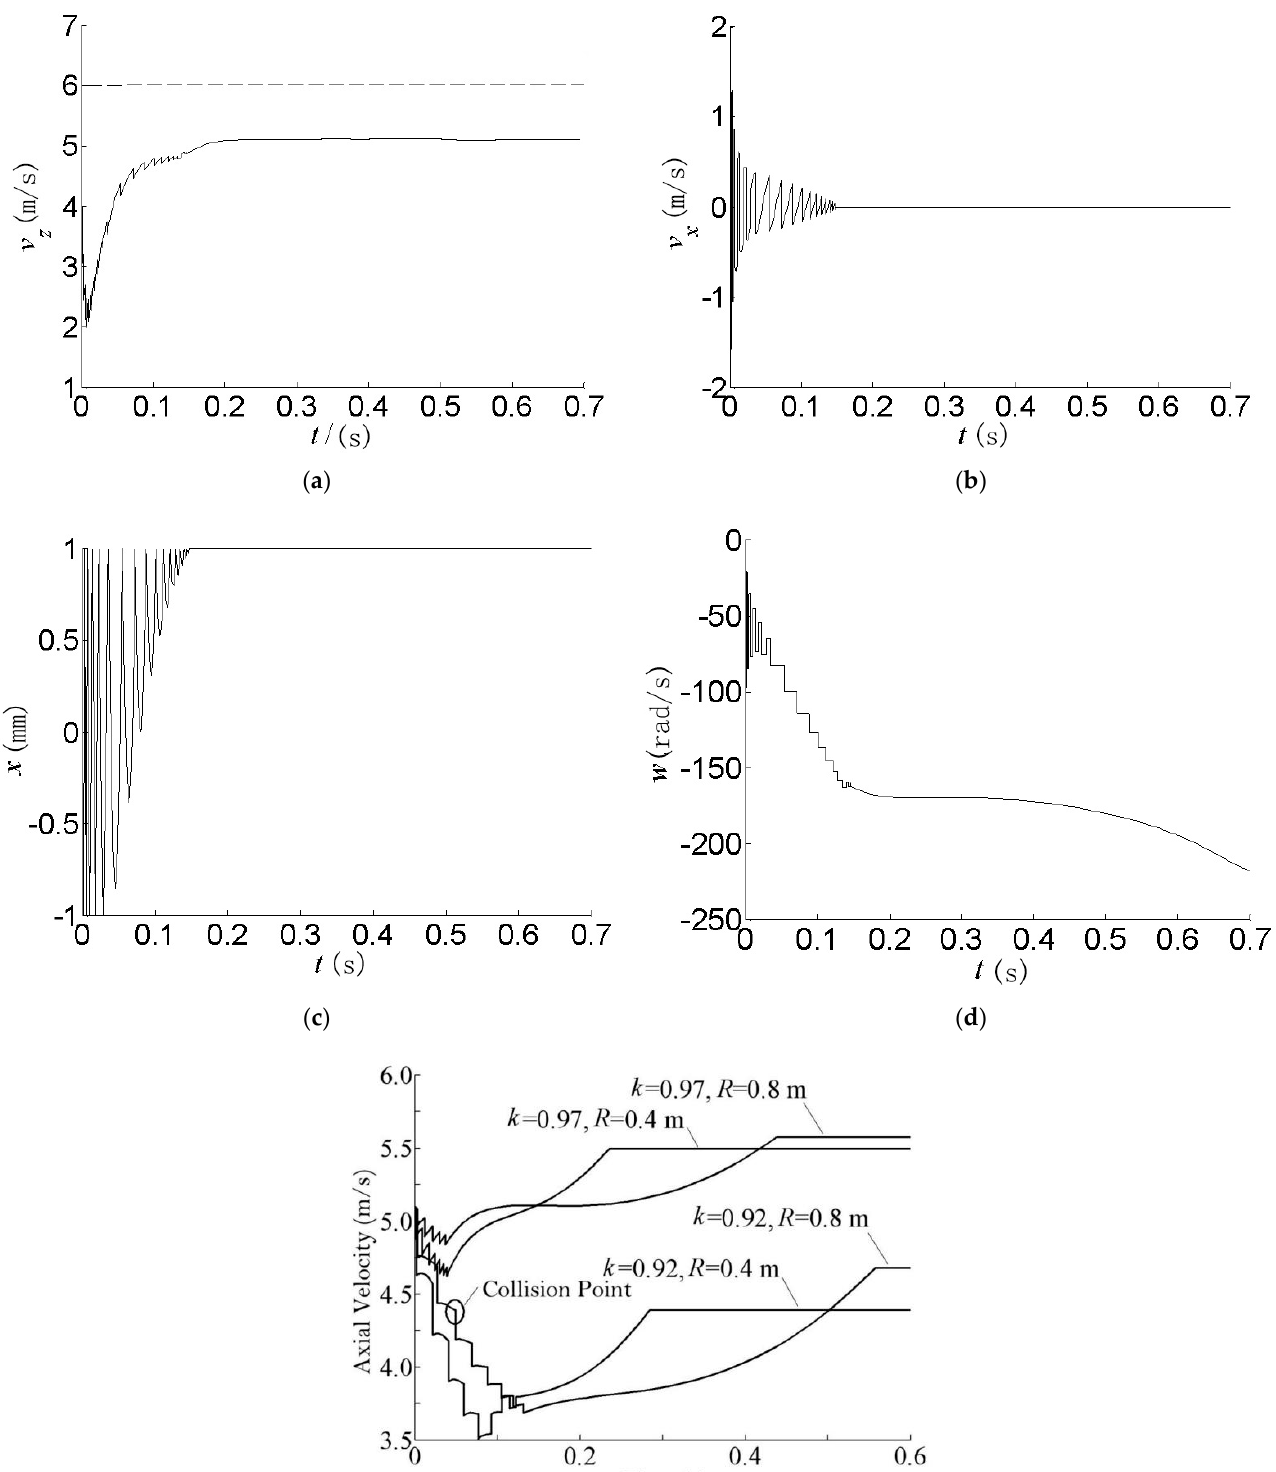
Figure 9. Atypical − bend section parameters: ( a ) axial velocity, ( b ) lateral velocity, ( c ) lateral displacement, ( d ) angular velocity, ( e ) sphere/pipe − diameter ratio and pipe − bending radius. At the beginning of the fuel element entering the bend, its transverse velocity large and the collision between the fuel element and the inner ‐ wall surface of the pipe is